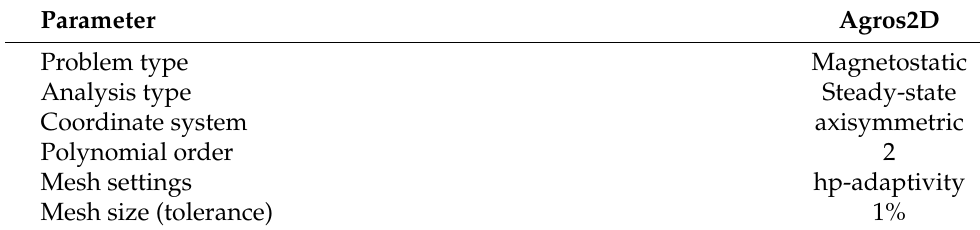
Figure 5. The convergence of the objective functions ( F 1 and F 2 ) in terms of the number of nodes with and without hp-adaptivity. ( a ) The image plots the dependence of F 1 , while ( b ) plots the dependence of the F 2 function on the number of nodes. Table 3. The settings used for Agros2D during the